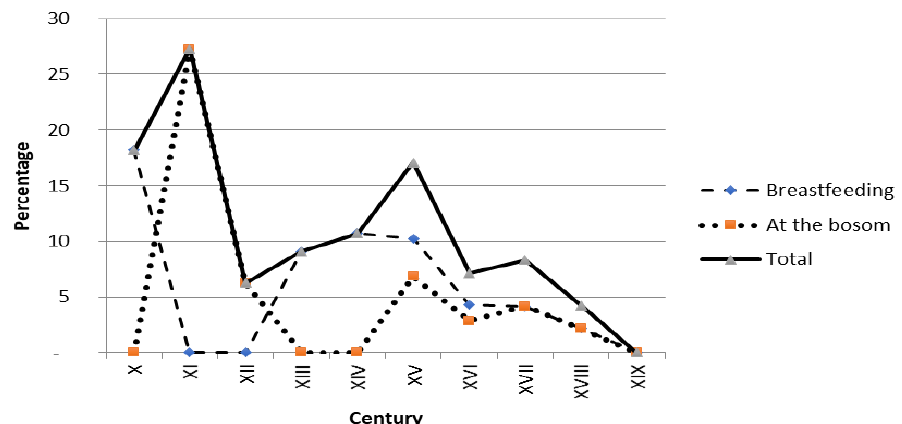
Figure 3. Representations of Mary nursing or pregnant (Spain, percentage of total works by century, tenth to nineteenth centuries). Source: Authors’ elaboration based on Trens (1946).